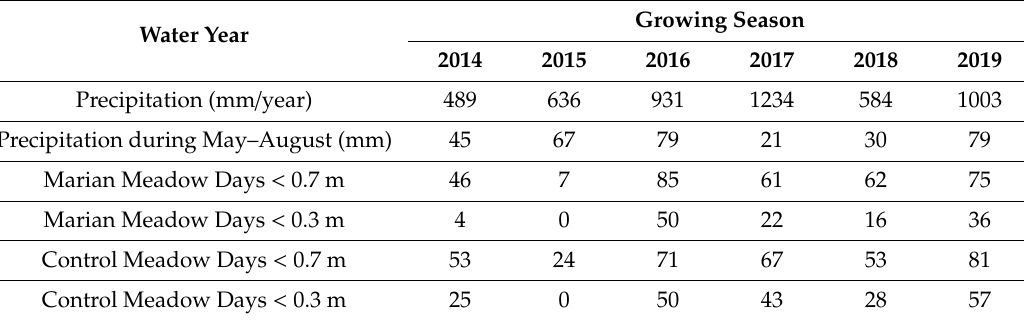
Table 6. Annual precipitation, precipitation during the growing season (1 April through 31 August), and number of days during the growing season with depth to groundwater < 0.3 m and < 0.7 m for 2014–2019